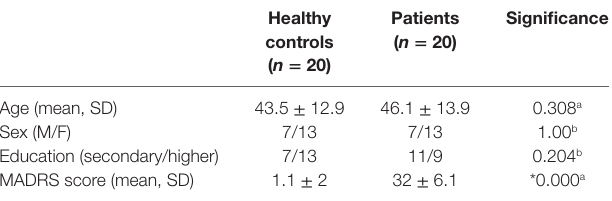
Table 1 | Demographic and clinical characteristics.